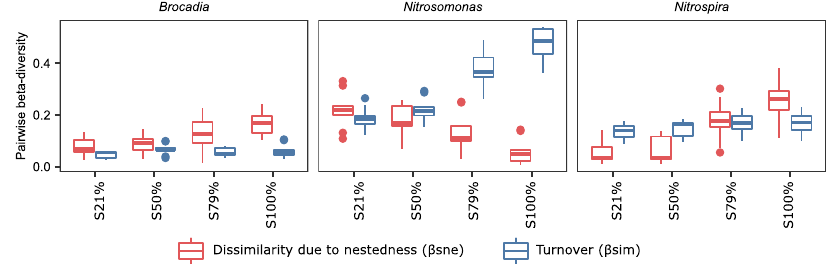
Fig. 4 Pairwise beta-diversity between S0% and other treatments using the Kaiju data from Fig. 3C. The presence-absence Sørensen index ( q = 0) was estimated as its two components: species turnover (i.e. the Simpson index) and dissimilarity due to nestedness. In the plot, center line: median, box limits: upper and lower quartiles, whiskers: 1.5 inter-quartile range, dots: